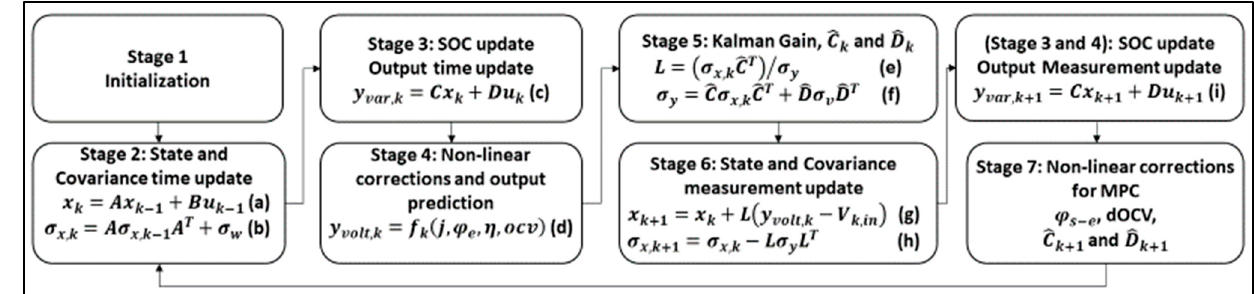
Figure 3. Software flow for PB ‐